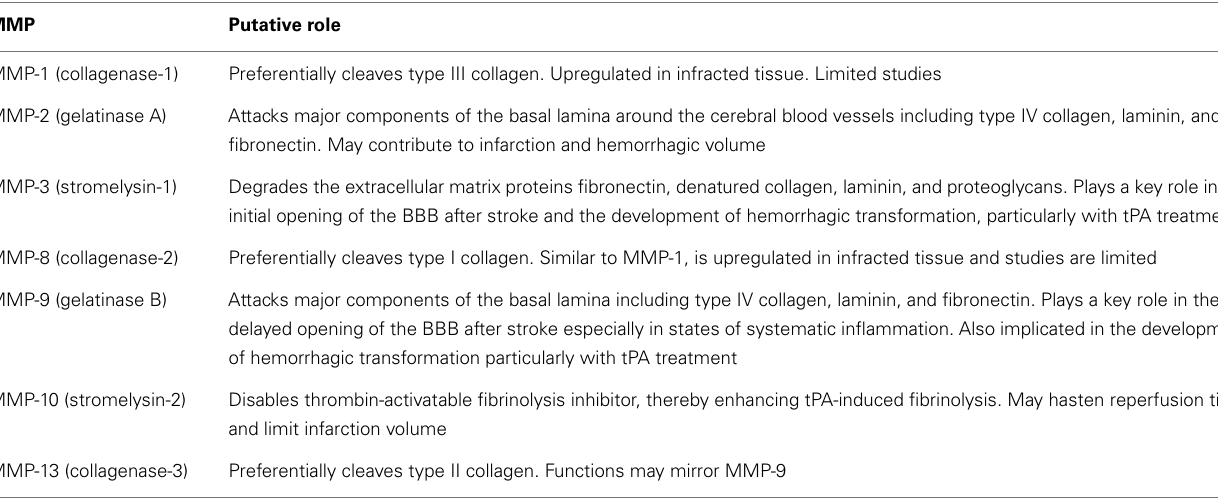
Table 1 | MMPs and their putative role in acute ischemic